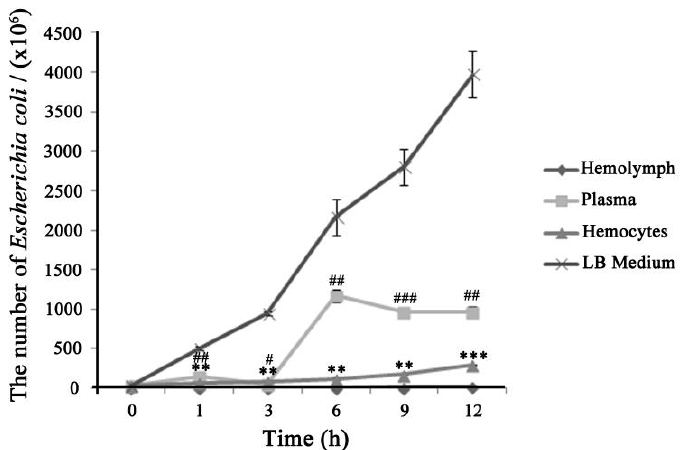
phenotype; type 2: larvae with more pigment pupated with a black body color, and died soon after